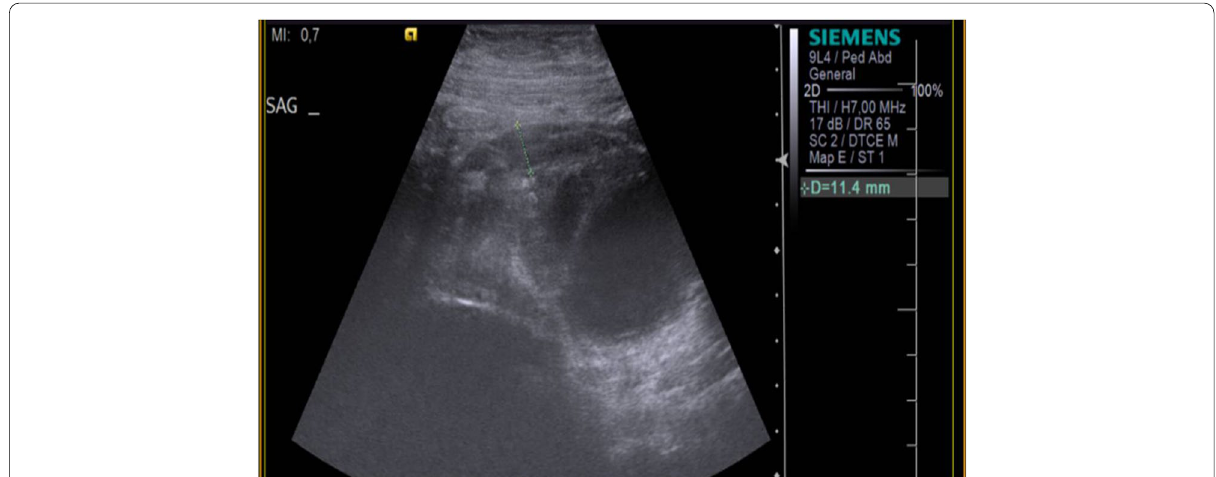
Fig. 2 USG image: in this image, the diameter of the appendix was measured as 11.4 mm